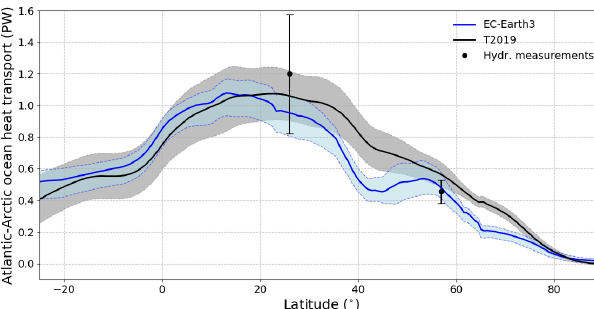
Figure 17. Ocean northward heat transport: the blue curve is the ensemble mean, and the light blue shading is delimited by the en- semble minimum and maximum. The black curve is taken from Trenberth et al. (2019). The hydrographic measurements at 26 ◦ N (RAPID) and 57 ◦ N (OSNAP) are shown as vertical